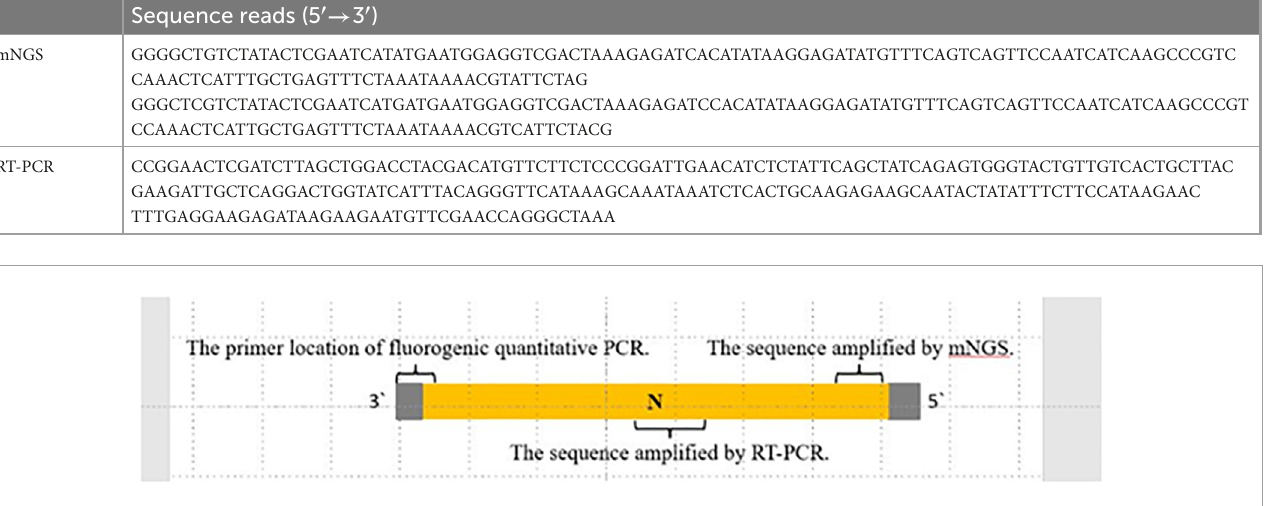
FIGURE1 The location and length of sequences. Sequences were identified by mNGS, RT-PCR/Sanger sequencing, and quantitative RT-PCR. Shown in proportion to the whole rabies virus nucleoprotein N